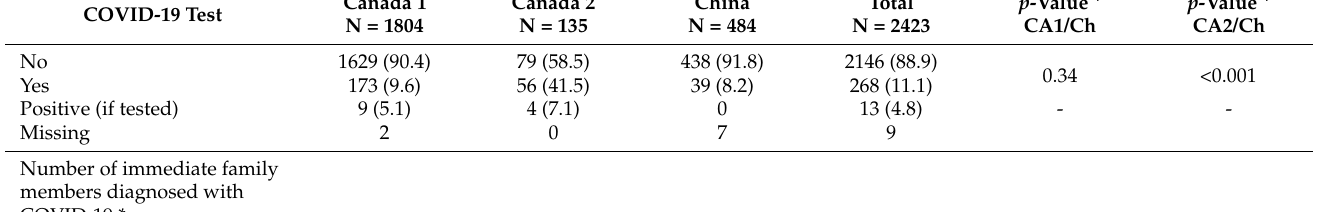
Figure 5. Overall satisfaction with life in pregnant persons. Comparison between prior to vs. since the start of the COVID-19 pandemic stratified by cohorts. Canada 1, n = 1646; Canada 2 (Can2), n = 120; China, n = 429 (missing values: Canada 1, n = 158; Canada 2, n = 15; China, n = 55). Wilcoxon signed rank test—comparing the differences between “prior to COVID-19” and “now” in each cohort. p < 0.001 (Canada 1); p < 0.001 (Canada 2); p = 0.295 (China).